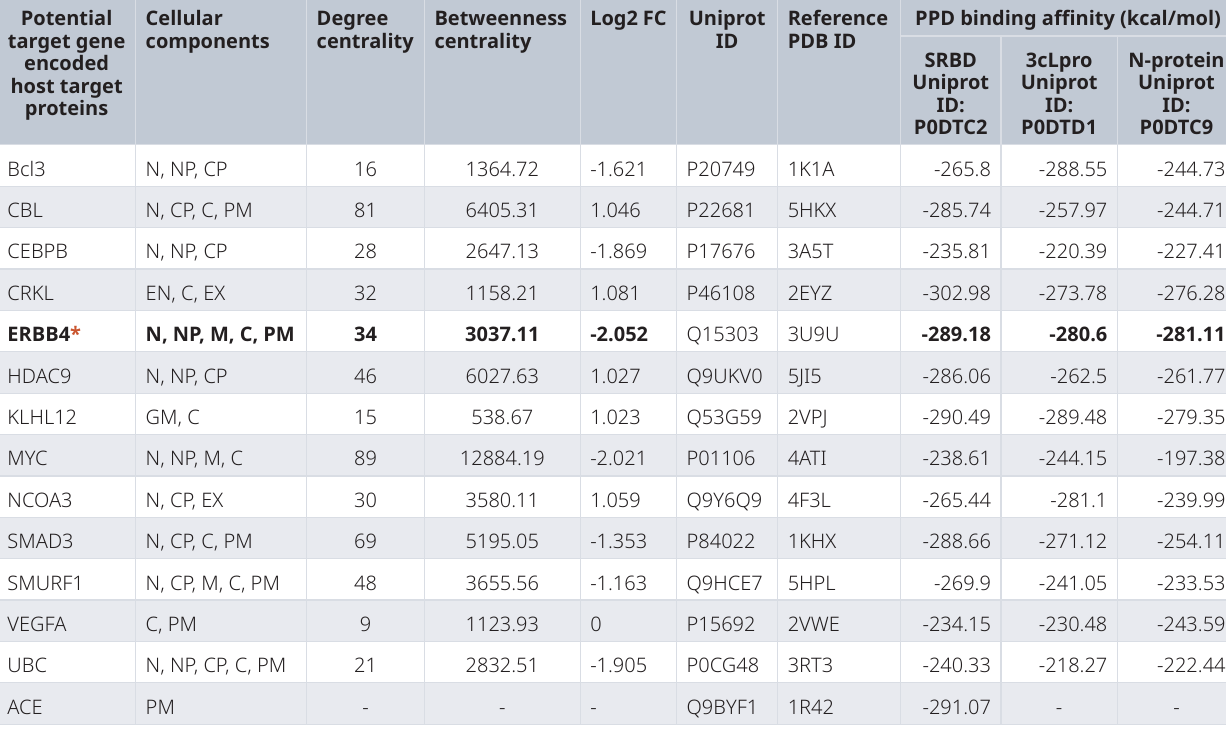
Table 3. List of drug targets and PPD interaction with SARS-CoV-2 proteins. Potential target